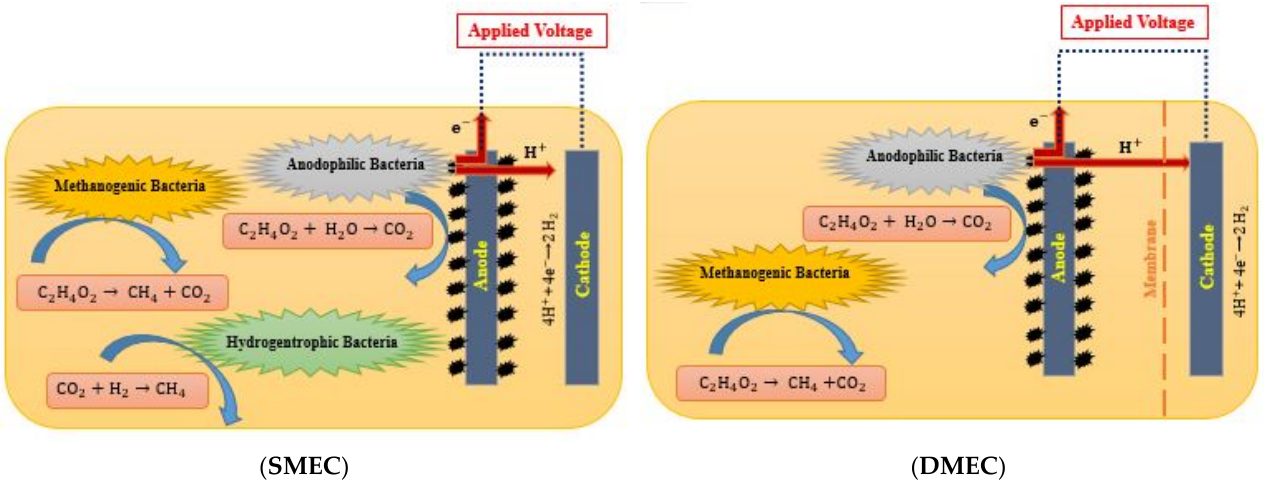
Figure 3. A view of microbial activities in the anode compartment.